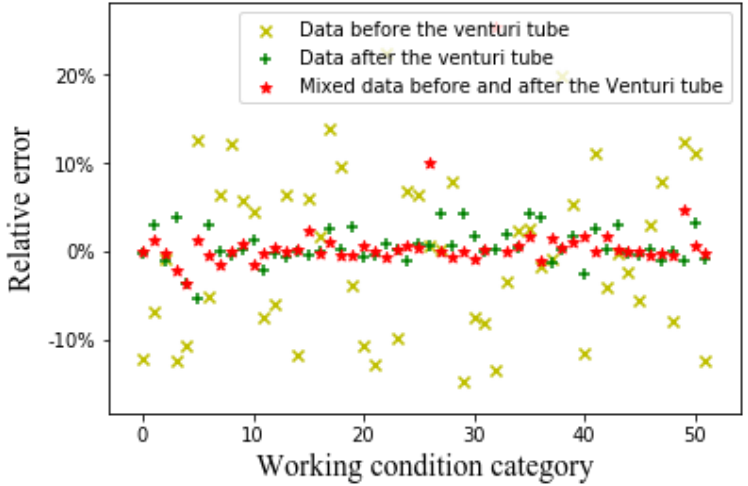
Figure 10. Relative error of gas flow rate with CNN algorithm.